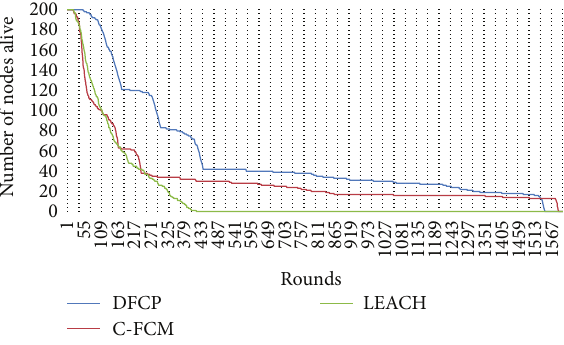
Figure 4: Total data delivered to the BS in 500 m × 500 m WSN.